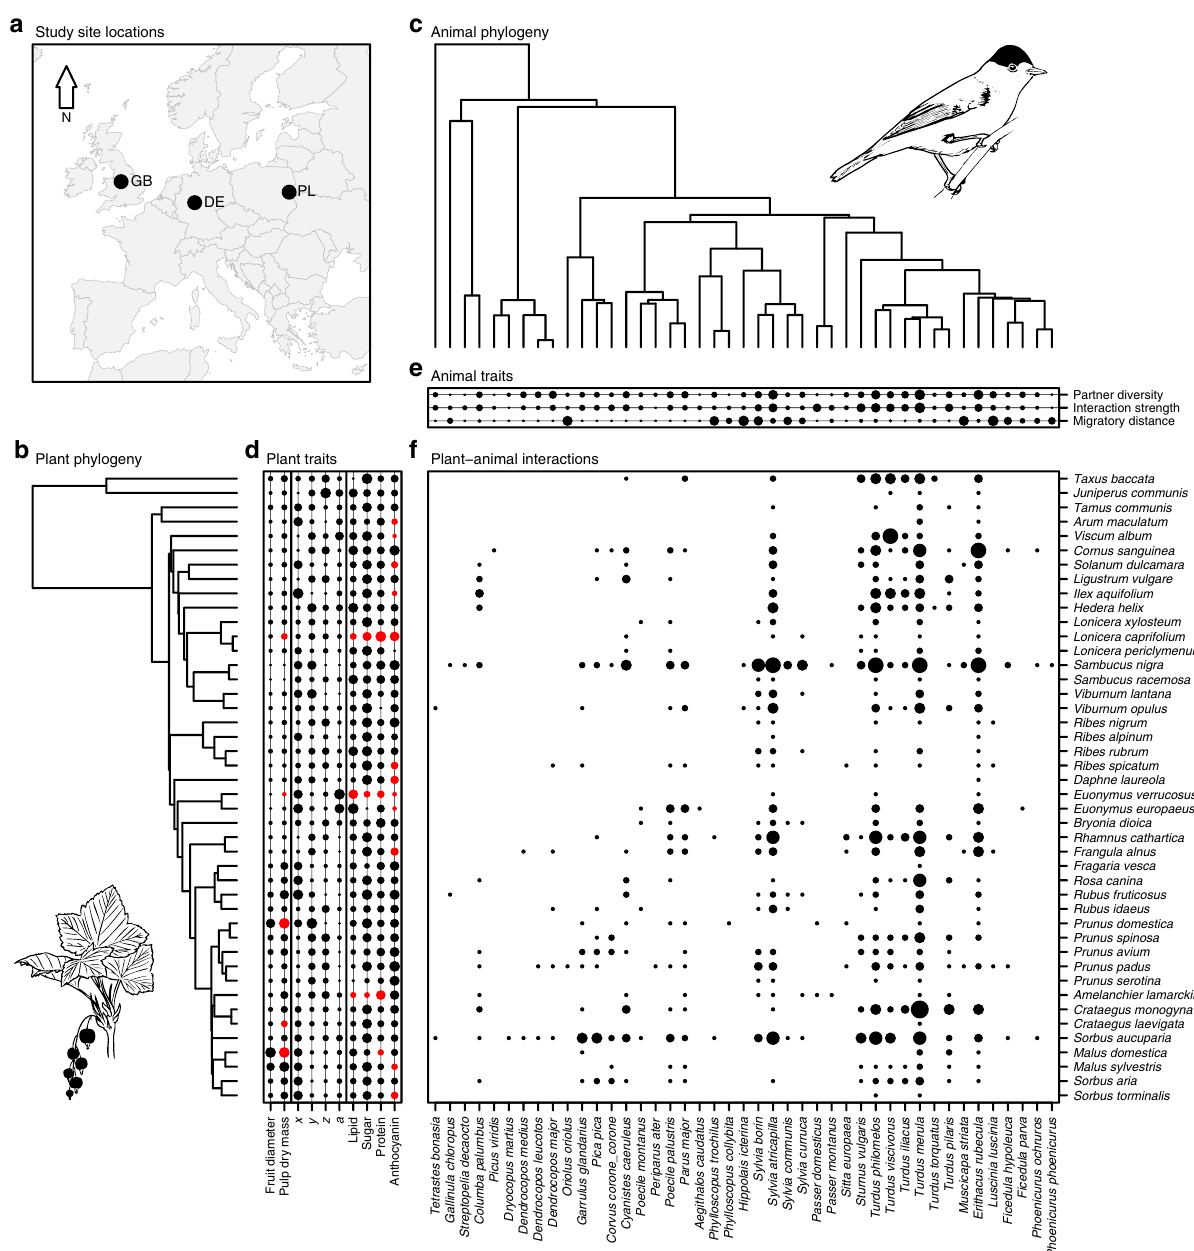
Fig. 1 Summary of the data from the three European plant – frugivore associations that have been used in the present study. a The locations of the three study sites, b , c the plant and animal phylogenies, d , e plant and animal traits, and f the pooled metaweb of plant – frugivore interactions (see Methods for details). The dots in a represent the locations of the plant – frugivore associations included in this study (GB: Snow and Snow 23 ; DE: Stiebel and Bairlein 58 ; and PL: Albrecht et al. 59 ). In d , e traits are scaled to the interval [0, 1], with larger dots indicating a larger relative trait value. In d ( x , y , z ) and ( a ) characterize the fruit colours of the plant species according to the visual perception of birds in tetrahedral colour space 37,38 , whereby ( x , y , z ) represent the chromatic components of fruit colouration and ( a ) represents fruit brightness (i.e., the achromatic colour component). Red dots in d indicate plant traits that have been inferred using Bayesian data augmentation (see Methods). In e the mean trait values of frugivores are shown for simplicity, although for a given frugivore species a trait could vary across the three study sites and across seasons (see Methods). In f the size of the dots depicting plant – frugivore interactions indicates the proportional occurrence of a given interaction across sites and seasons (with larger dots representing interactions with higher spatiotemporal constancy). Note that even though we present the pooled metaweb as a summary in f , we explicitly accounted for the fact that individual networks were sampled in different localities and during different seasons in the analysis. The map in a was created in R 75 using the package rworldxtra 79 . Made with Natural Earth. The drawings of black currant ( Ribes nigrum ) in b and Eurasian blackcap ( Sylvia atricapilla ) in c were created by J. Methods). To quantify the reliability of the colour – reward rela- Across the three localities, the nutritional rewards of fruits were tionships, we used marginal r 2 -values ( r m 2 ) 39 that measure the consistently related to fruit brightness, but not to the chromatic variation in nutrient content that is explained by fruit colour colour components of the avian colour space (Table 1; Fig. 2c). while accounting for the phylogenetic relatedness of plants. Fruit brightness indicated with low to moderate reliability the